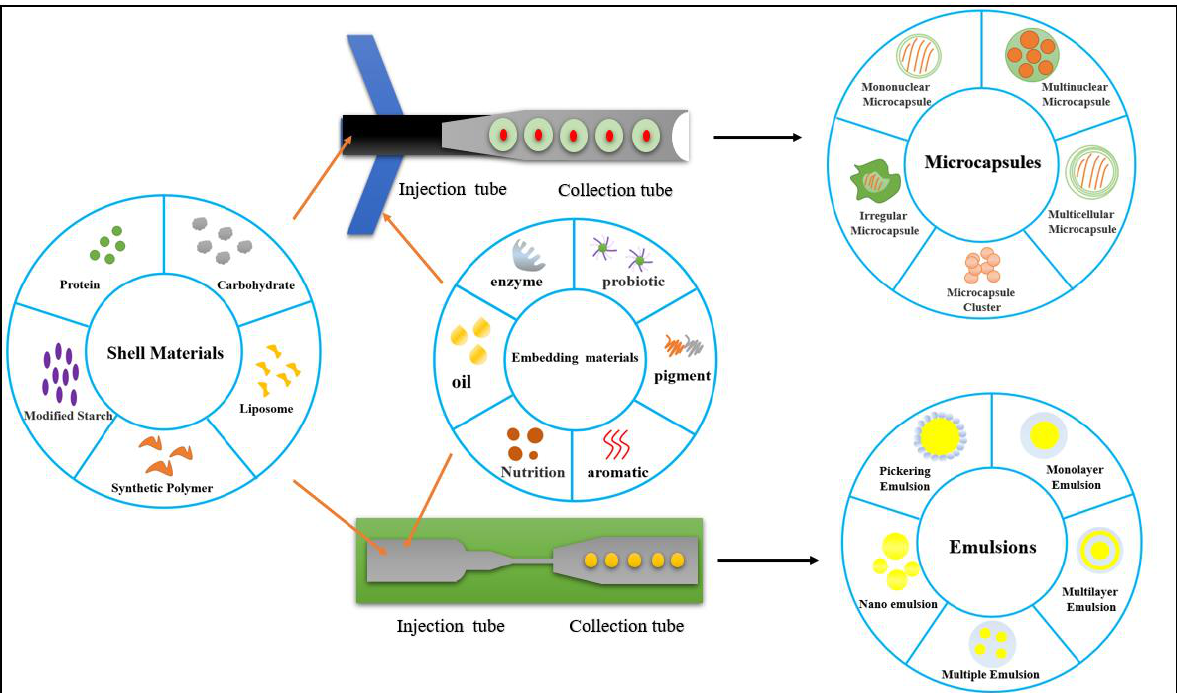
Figure 4. Droplet microfluidics for emulsions and microcapsules.